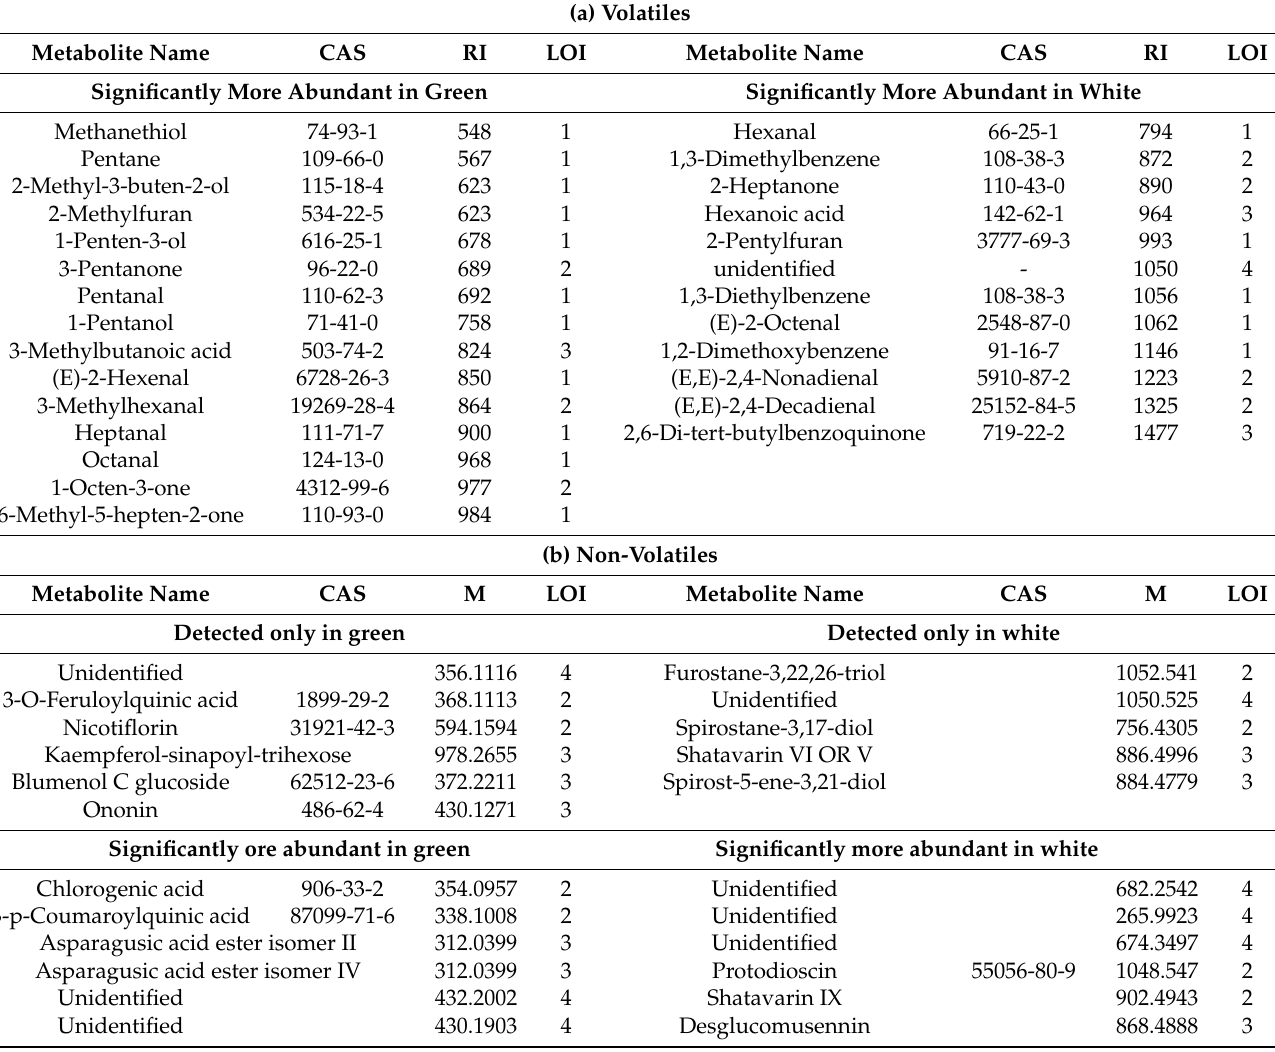
Table 1. Overview of characteristic ( a ) volatiles and ( b ) non-volatiles detected in either significantly different abundances between raw green and white asparagus (adjusted p value ≤ 0.05) or in only one asparagus type based on the two seasons. The CAS numbers (when applicable), experimental retention indices (RIs) and calculated monoisotopic mass (M) are given. The level of identification (LOI) provided is based on the Metabolomics Standards Initiative guidelines [24]. For a complete list of all detected compounds in both seasons (2019 and 2020) see Tables